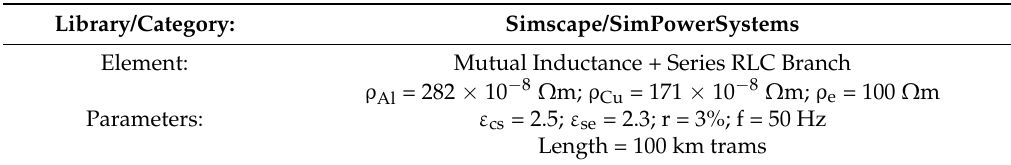
Table 2. Main characteristics of 220 kV cable.